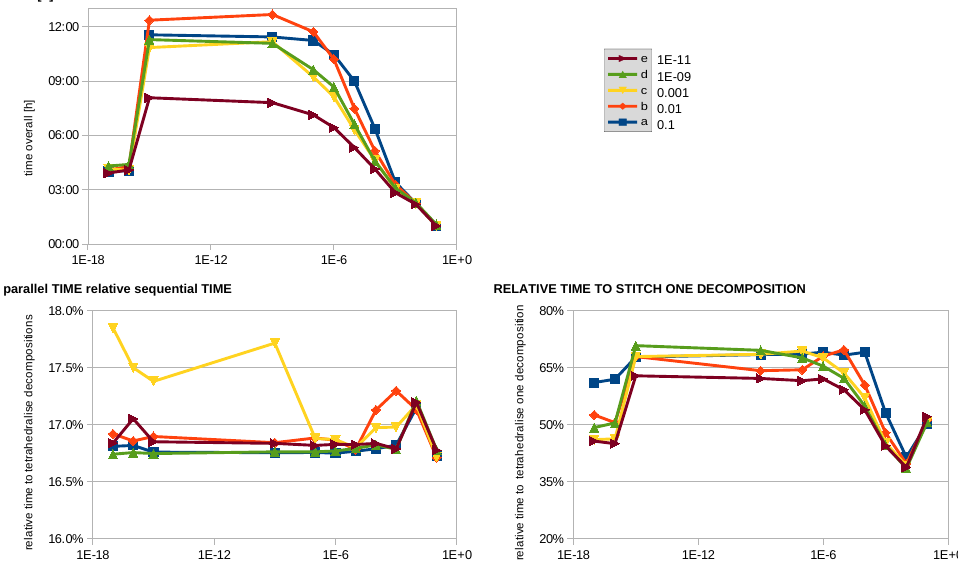
Figure 11. Results with six threads for the set of groups and three threads for each group of the city centre of Erfurt, grouping each building with its parts into separate groups ( x -axis: angular precision ζ , different colours for each precision (cid:101) = ε = σ = λ value).